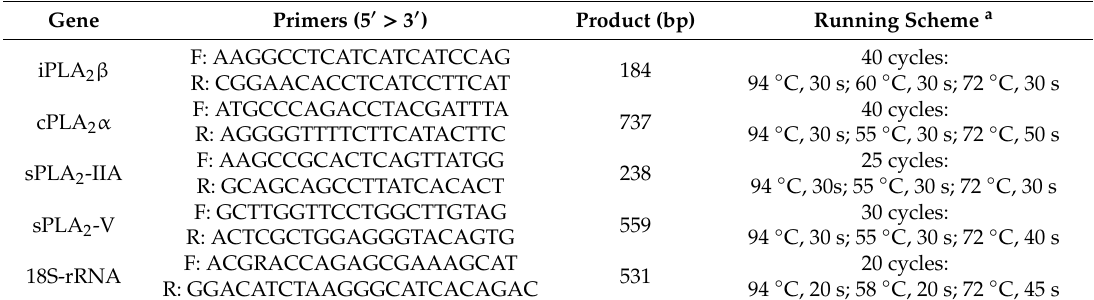
Table 1. Primers and running schedules used in Reverse